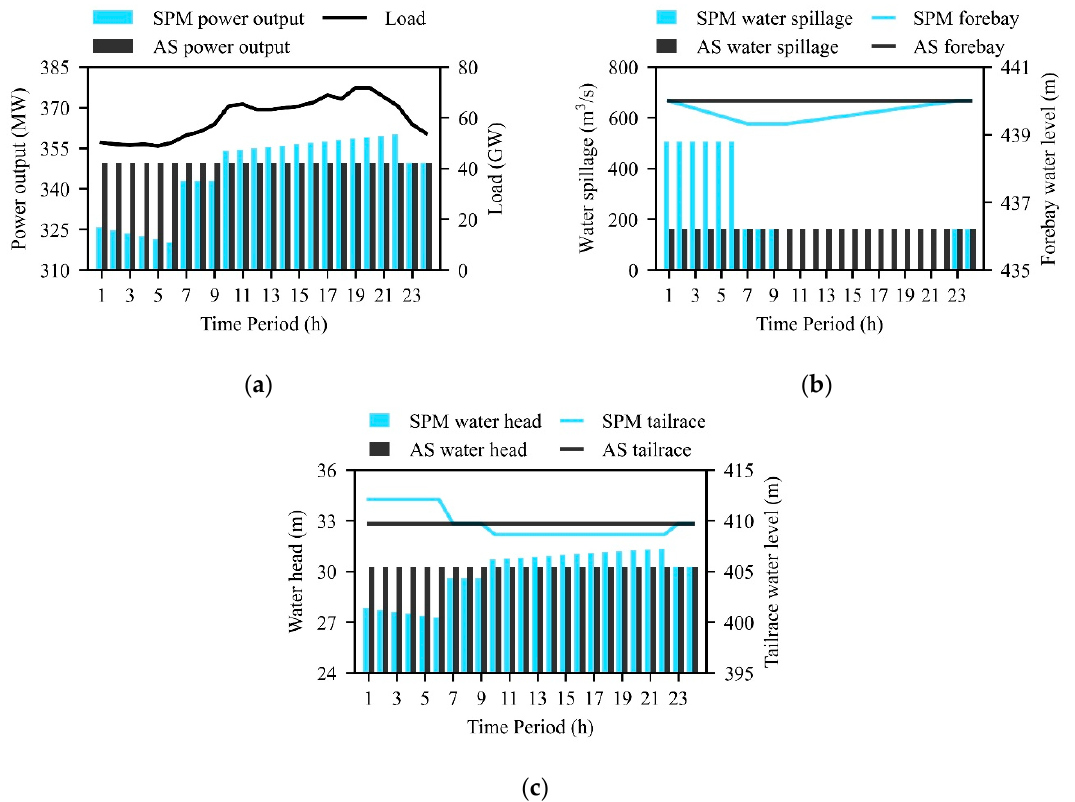
Figure 6. The results of SPM and AS. ( a ) Power output; ( b ) water spillage and forebay water level; ( c ) tailrace water level and water head.